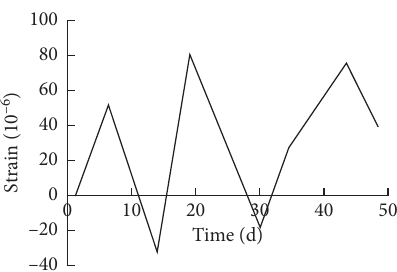
Figure 5: The tensile-compressive strain alternate distribution of the bolt body.